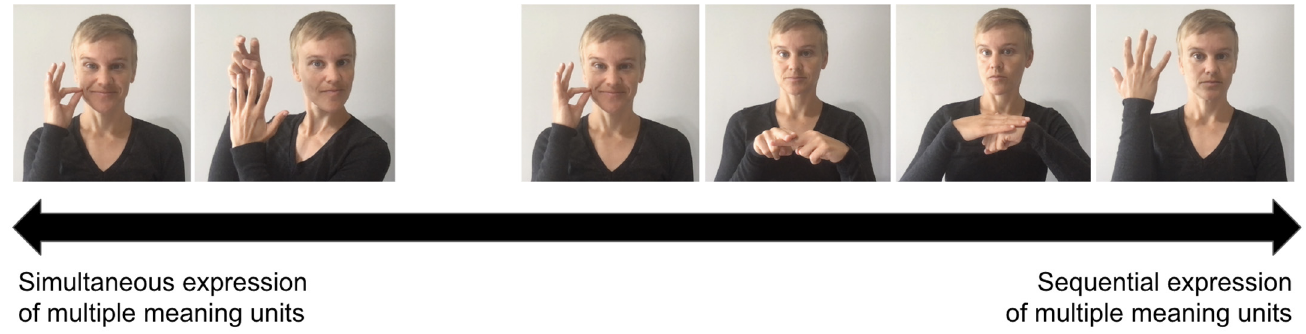
Figure 1. Simultaneous and sequential expression.